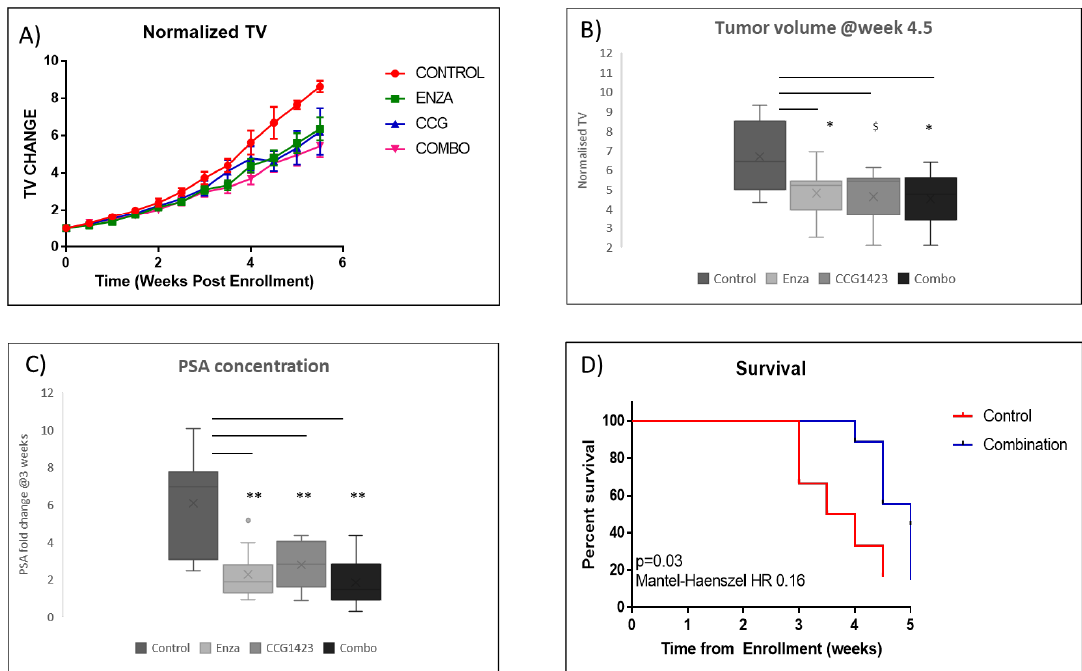
Figure 2. Fox Chase CB17 SCID castrated mice were implanted with LuCaP 35CR tumour